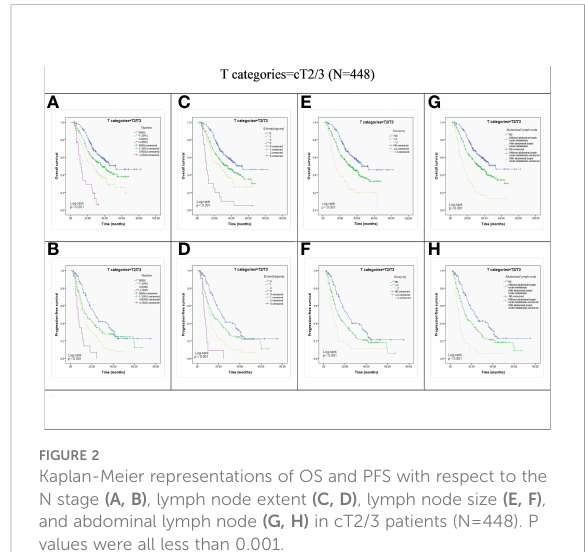
FIGURE 1 Kaplan-Meier representations of OS and PFS with respect to the N stage (A, B) , lymph node extent (C, D) , lymph node size (E, F) , and abdominal lymph node (G, H) in cT2/3/4 patients (N=555). P values were all less than 0.001.